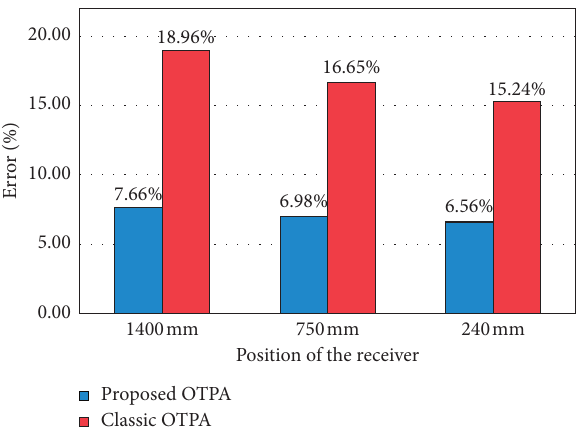
Figure 31: Errors of the improved and classic OTPA calculated in function of the receiver’s